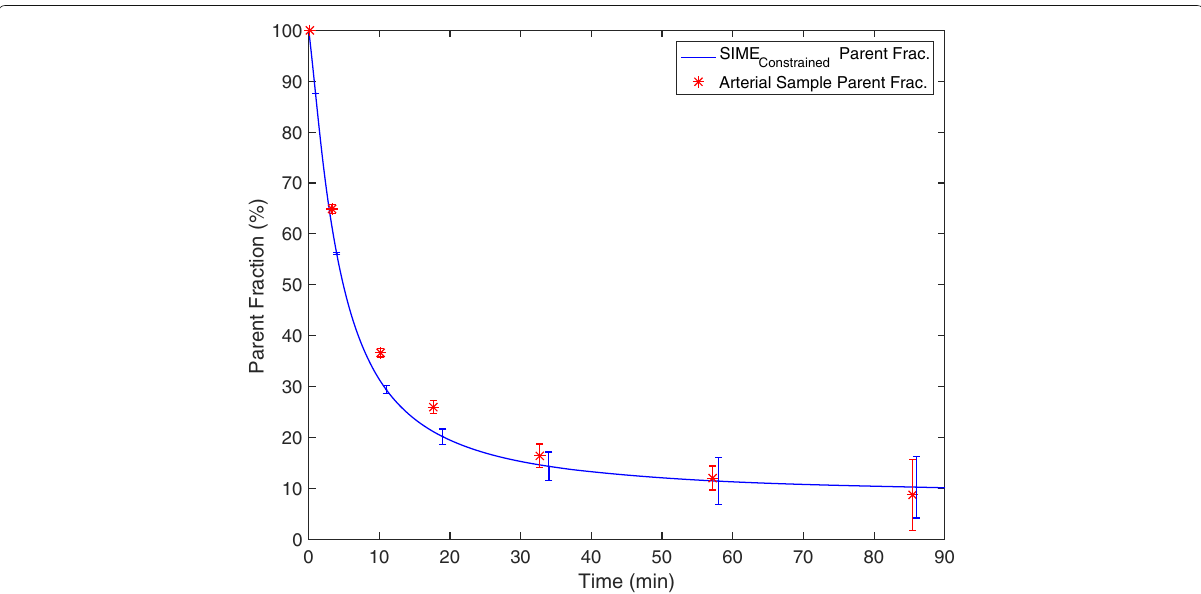
Fig. 4 Average of the parent fractions estimated using the SIME constrained plotted together with average of parent fractions derived from plasma samples. Error bars represent the variation between estimated and measured parent fraction curves from 10 datasets